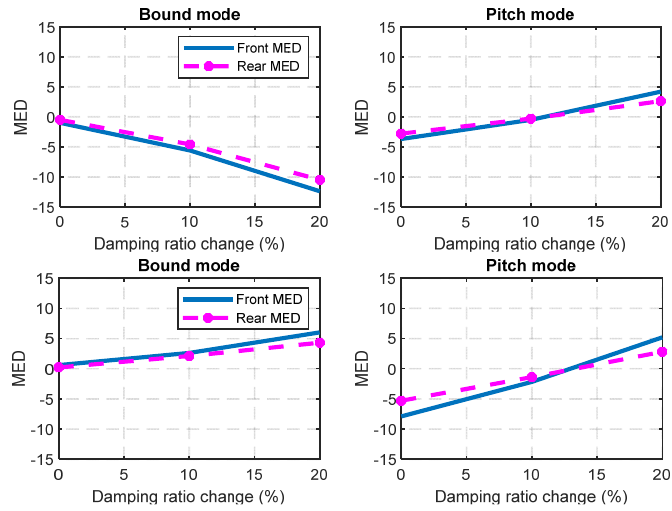
Figure 14. Difference of rear MED between baseline and spring fault.